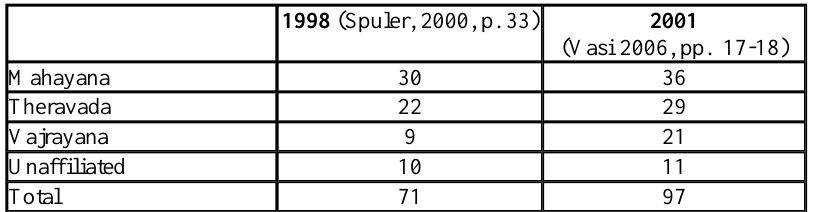
Table 3: Numbers of Victorian Buddhist Organizations in 1998 and